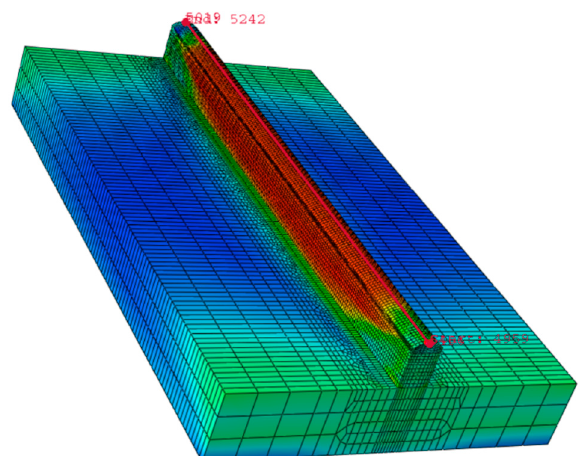
10 of 13 Figure 8. Compression behavior of SS 316L as a function of interlayer delay. 4.6. Thermal Analysis